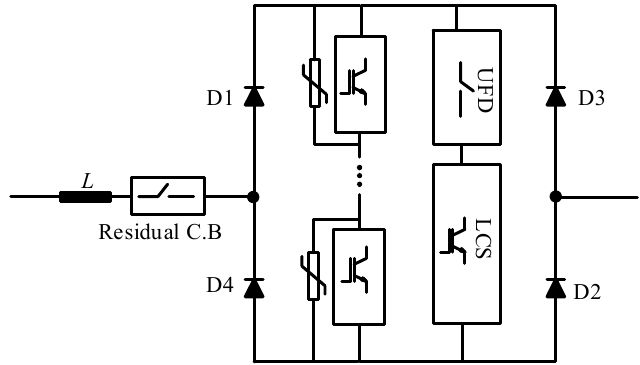
Figure 3. Proposed bridge configuration of the hybrid breaker.